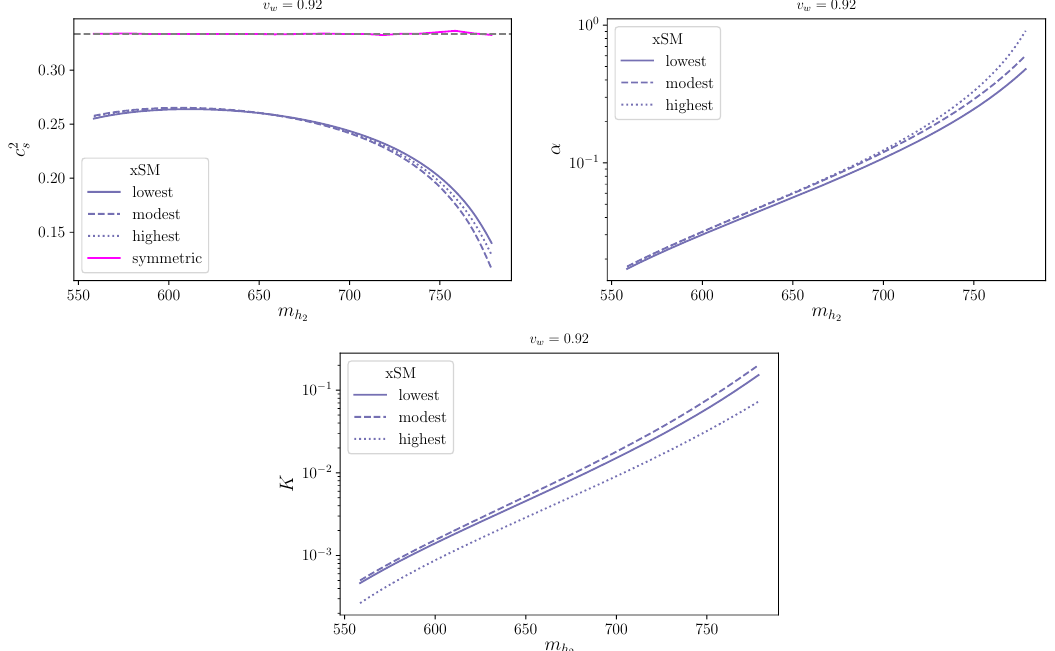
Figure 10 . xSM : the top left panel shows the speed of sound calculated in the symmetric and broken phase using eq. (2.47) at the different levels of diligence. The gray dashed line corresponds to the bag model with c 2 = 1 / 3 . The symmetric phase (solid magenta) is only shown at highest s diligence. The top right panel shows the strength of the phase transition at the different levels of diligence using eq. [(2.5), (2.12), (2.49)]. The bottom panel shows the kinetic energy fraction at the different levels of diligence where the lowest and modest diligence use fits for κ to get K and the highest diligence uses eq. (2.55). The temperatures are set to T (2.4), T (2.11), and T (2.27) for n p f the lowest, modest, and highest diligence respectively. The numerical calculation of the speed of sound only enters in the highest diligence of α